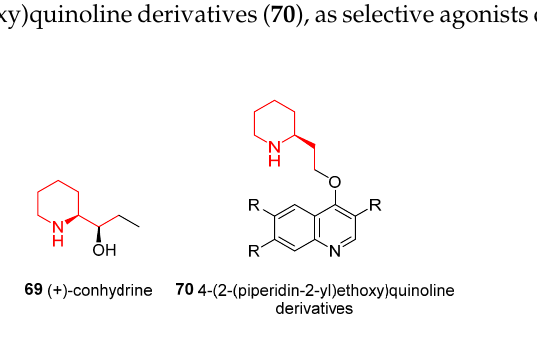
Figure 8. Structure of (+)-conhydrine and general structure of 4-(2-(piperidin-2-yl)ethoxy)quinoline derivatives.